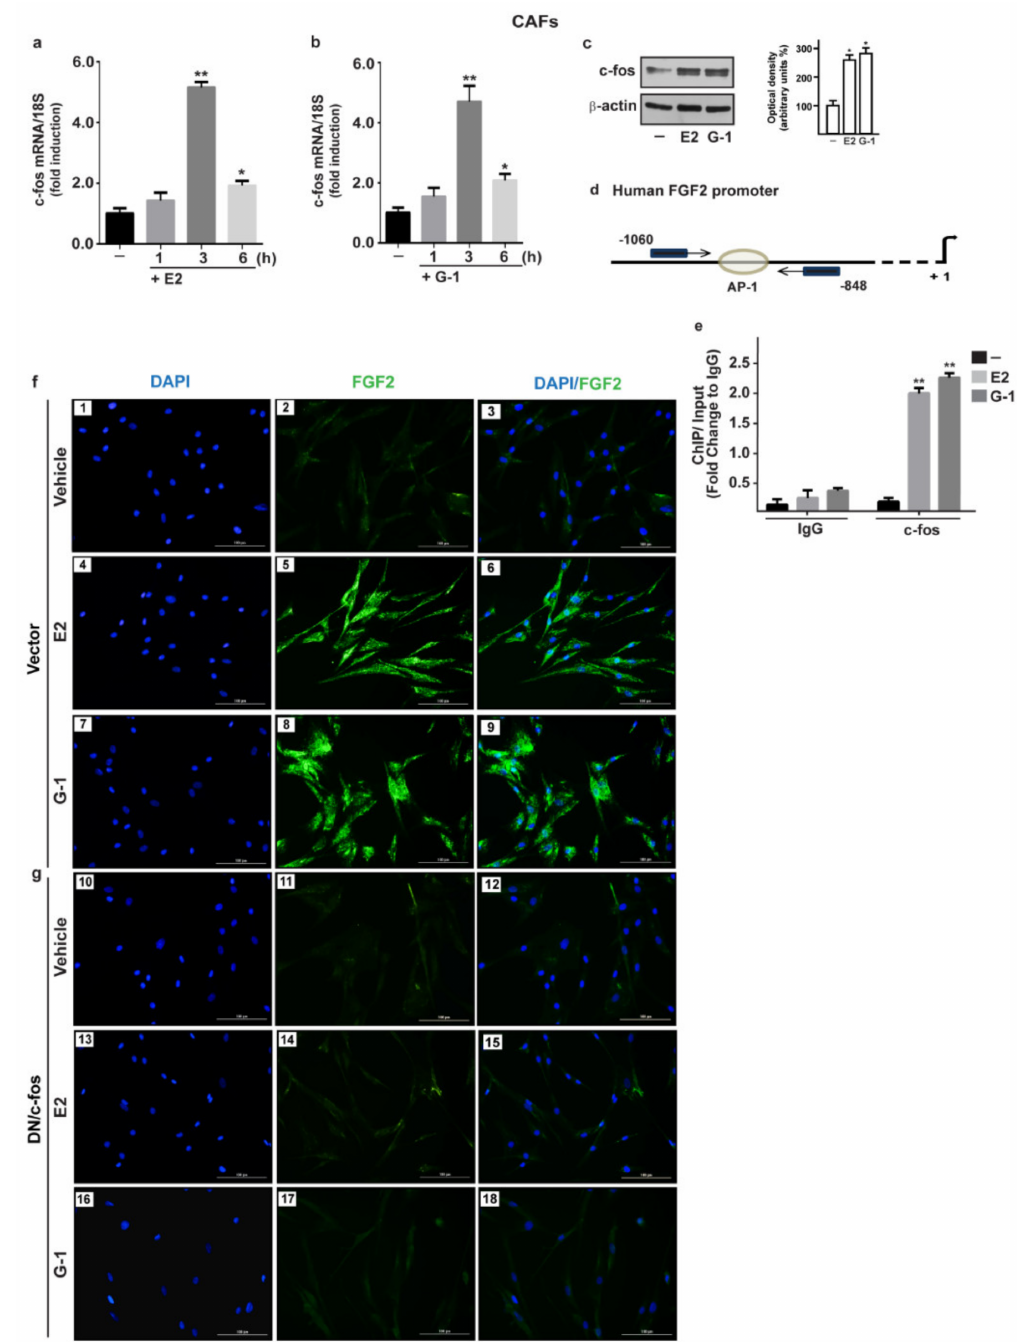
Figure 3. The oncogene fos (c-fos) is involved in the up-regulation of FGF2 by E2 and G-1 in CAFs. 10 nM E2 ( a ) and 100 nM G-1 ( b ) induced c-fos mRNA expression, as evaluated by qPCR. Values were normalized to 18S expression and shown as fold changes of c-fos mRNA expression upon E2 and G-1 treatments respect to cells exposed to vehicle (-). ( c ) The treatment for 3 h with 10 nM E2 and 100 nM G-1 up-regulated c-fos protein, which is recruited to the AP-1 site located within the FGF2 promoter region (-1060/-848; the transcriptional start site is indicated as + 1), as ascertained by Chromatin Immunoprecipitation (ChIP)-qPCR assay ( d , e ). Data were normalized to the input and reported as fold changes respect to Immunoblobulin G (IgG). Each column represents the mean ± SD of three independent experiments performed in triplicate. In immunoblot experiments β -actin